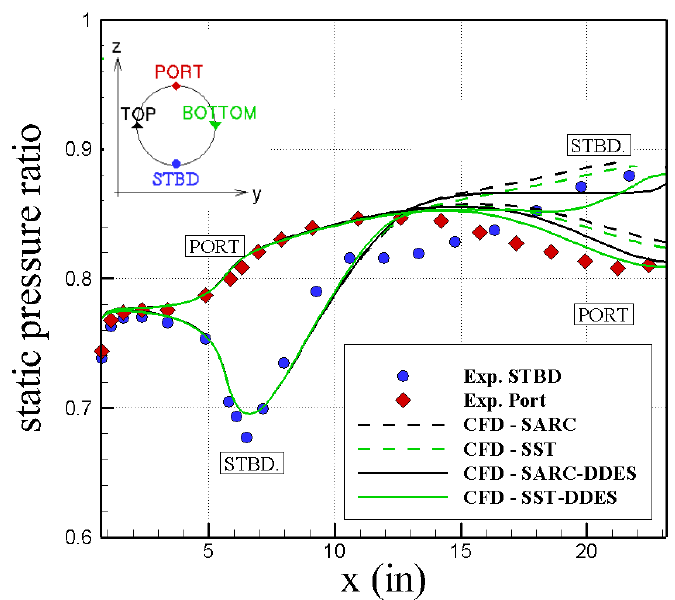
Figure 10. Turbulence model effects on CFD predictions of wall static pressure. Time-averaged solutions are shown for the NASA baseline grid. Static pressure ratio ( p f / p 0 ∞ ) is the ratio of averaged engine face static pressure to free-stream total pressure.